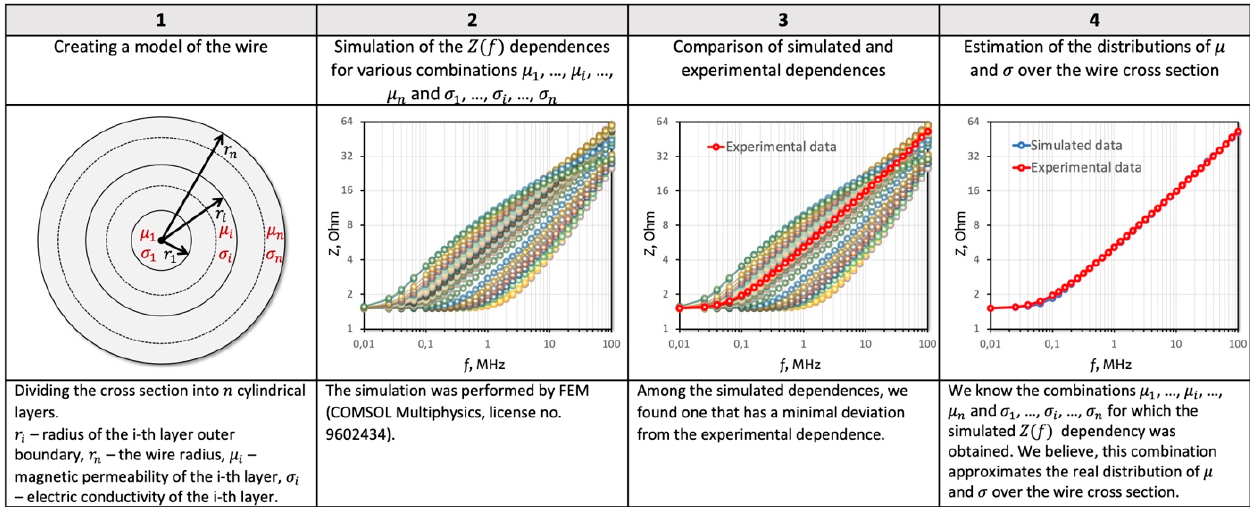
Figure 1. Algorithm for comparing the simulated and experimental frequency dependences of the impedance.